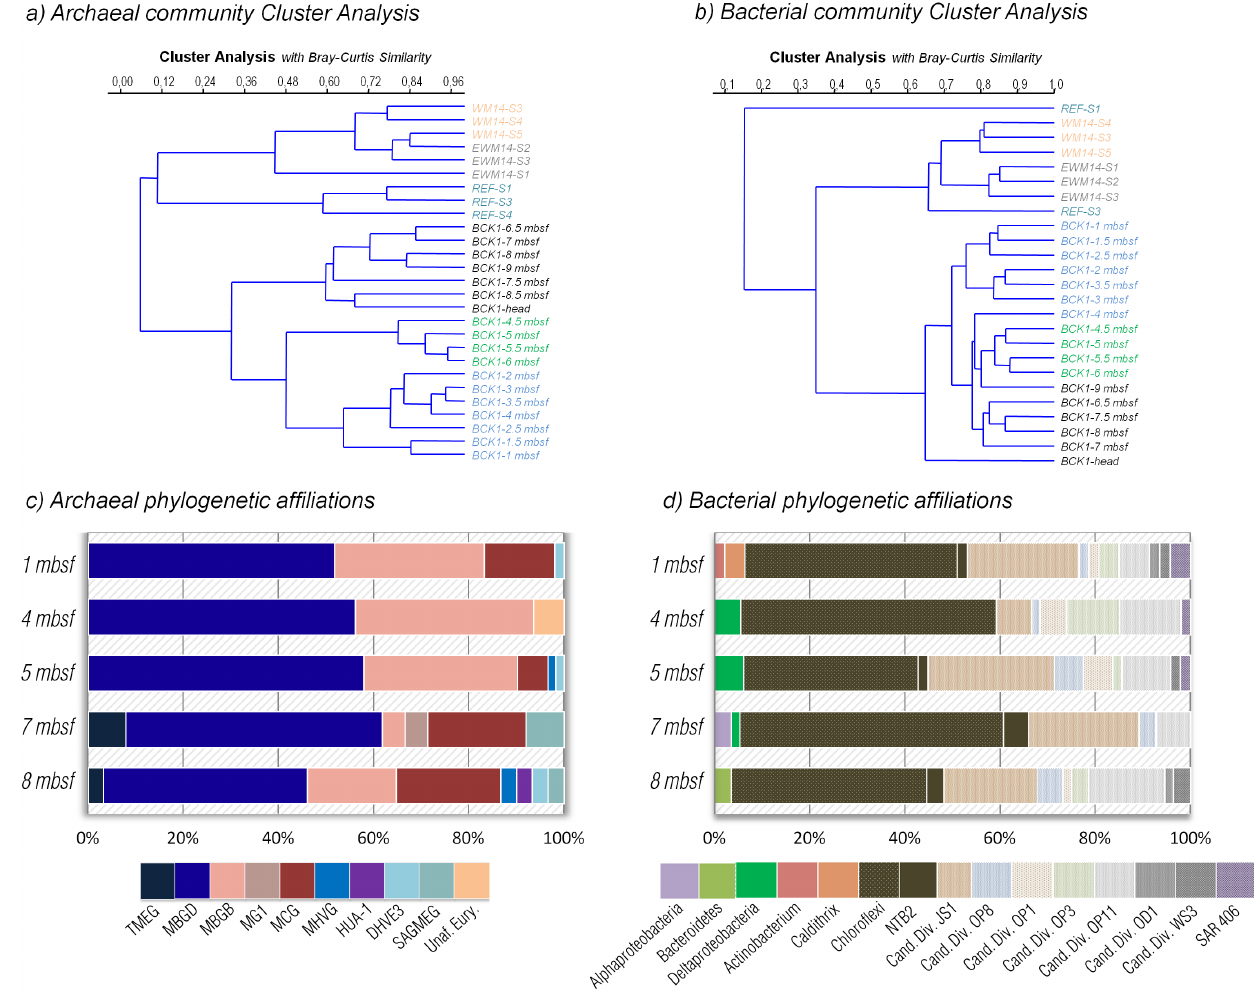
Figure 2. Microbial diversity. Clustering analyses using unweighted pair-group average (UPGMA) and Bray-Curtis Similarity measure of the a) archaeal and b) bacterial community structures visualizing the ARISA dataset. Depth distribution of the c) archaeal and d) bacterial phylogenetic affiliations of the 16S rRNA-derived sequences at 1, 4, 5, 7 and 8 mbsf sediment layers of BCK1. WM14 (White Microbial mat), EWM14 (Edge of White Microbial mat) and REF (reference outside active seepage area) samples were previously analyzed with the same material and method in Vigneron et al 2013 and corresponded to archaeal community structure of the surface sediments of the Sonora Margin. TMEG, Terrestrial Miscellaneous Euryarcheotal Group; MBGD/B, Marine Benthic Group D/B; MG I, Marine Group I; MCG, Miscellaneous Crenarchaeotic Group; MHVG, Marine Hydrothermal Vent Group; Hua1, Huasco archaeal group 1; DHVE3, Deep-Sea Hydrothermal Vent Euryarchaeotal Group 3; SAGMEG, South Africa Gold Mine Euryarchaeotal Group.